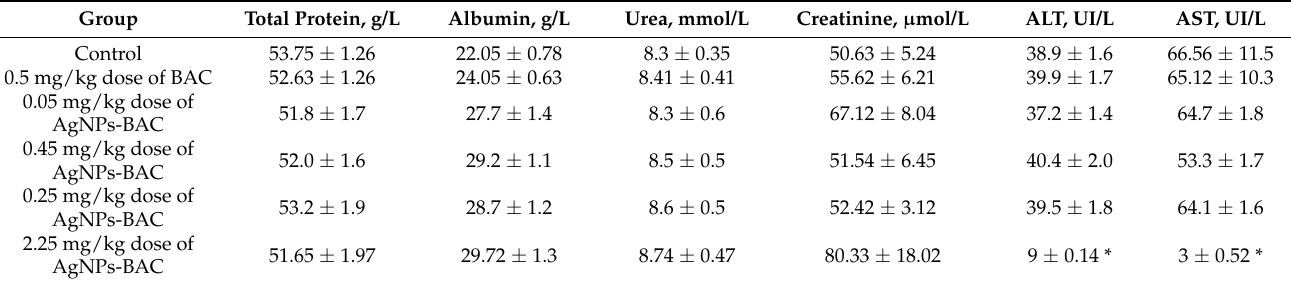
Table 3. Biochemical examination results (M ± m).